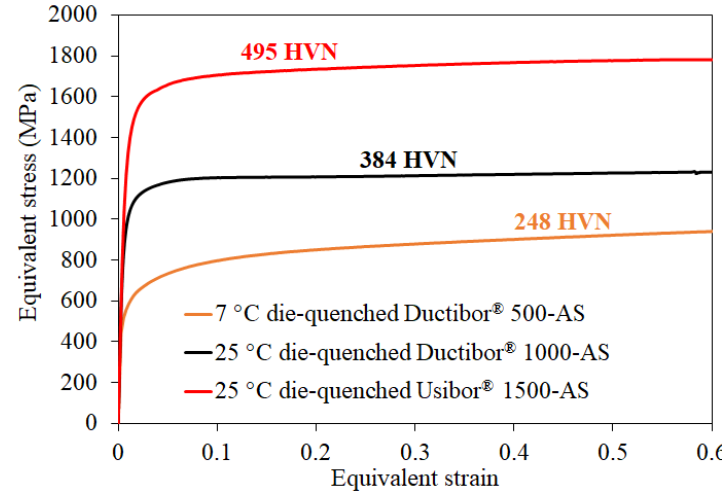
Figure 9. The flow curves of Ductibor ® 500-AS [8], Ductibor ® 1000-AS, and Usibor ® 1500-AS in the cold die-quenched condition. Note that all hardening curves were obtained based on the tensile and shear test data (shear-conversion technique [36]).